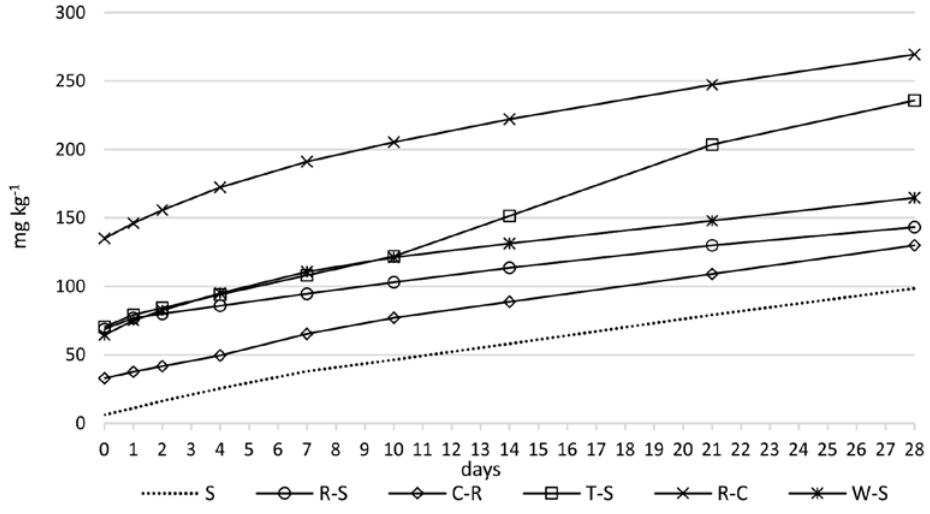
Figure 3. Cumulative carbon dioxide (expressed as CO 2 -C) evolved from the amended soils during incubation. Amendments: R-S = Reed sweet-grass digestate, C-R = Common reed digestate, T-S = Tufted sedge digestate, R-C = Reed canary grass digestate, W-S = Woollyfruit sedge digestate, S = unamended